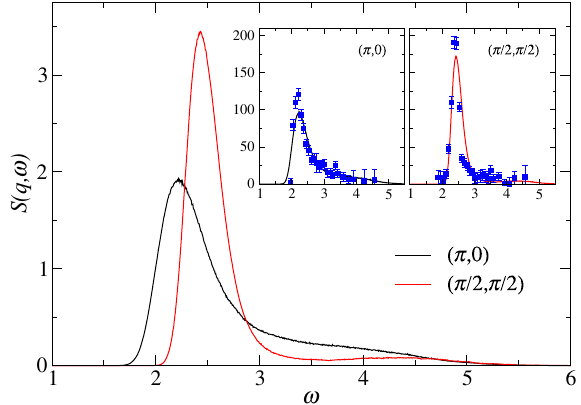
FIG. 11. Spectral functions at q ¼ ð π ; 0 Þ and ð π = 2 ; π = 2 Þ obtained using unconstrained SAC with the parametrization in Fig. 1(a). The insets show comparisons with the experimental data [33], where we have only adjusted a common amplitude to match the areas under the